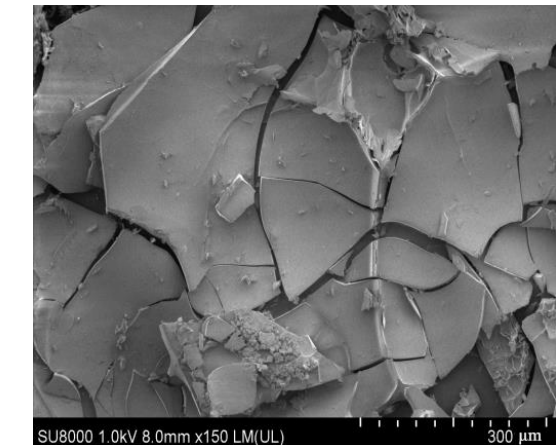
Figure 6. SEM Comparison of Common Chrome Gel (Left) and Novel Naphthol Gel (Right).